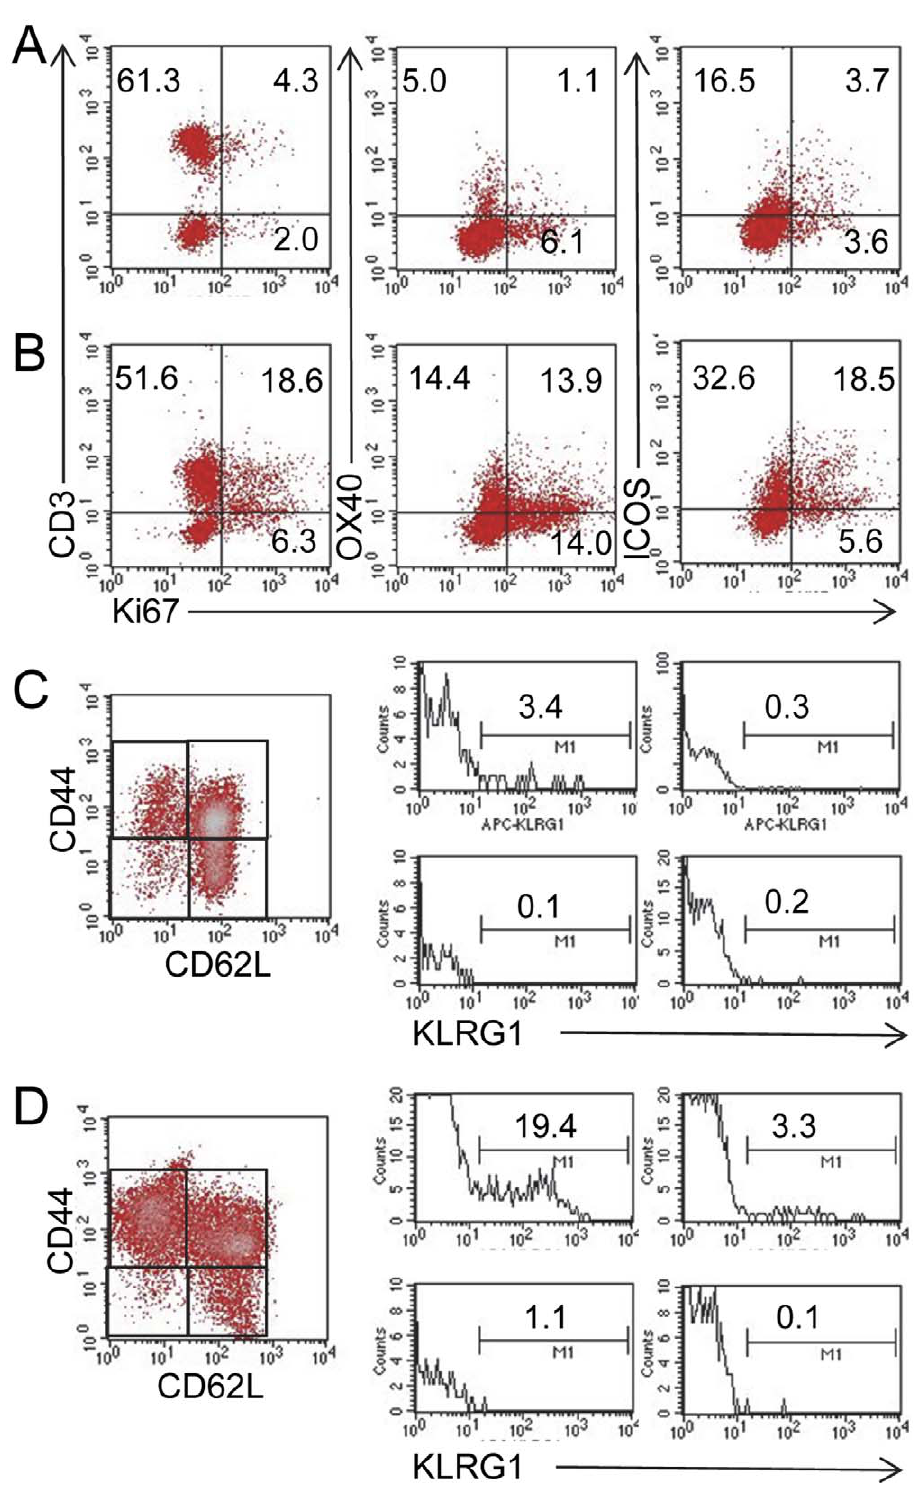
Figure 5. MLN cells from Roquin san/san mice are proliferative and have more SLECs. Based on Ki67 staining, (panel B ) a greater proportion of OX40 + cells and ICOS + MLN cells were proliferating T cells compared to MLN cells from (panel A ) normal mice. Representative staining from 1 normal and 2 Roquin san/san mice. Similarly, there was a greater proportion of CD44 hi CD62L lo KLRG1 + SLECs present in MLN cells of (panel D ) Roquin san/san mice compared to (panel C ) normal mice. Representative data from 3 normal and 3 Roquin san/san mice.